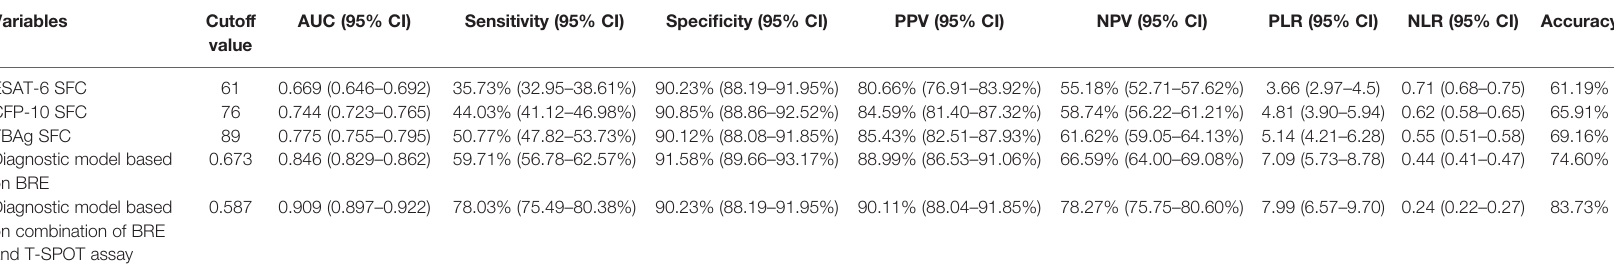
TABLE 3 | The performance of various methods for distinguishing between ATB and LTBI in Qiaokou cohort.